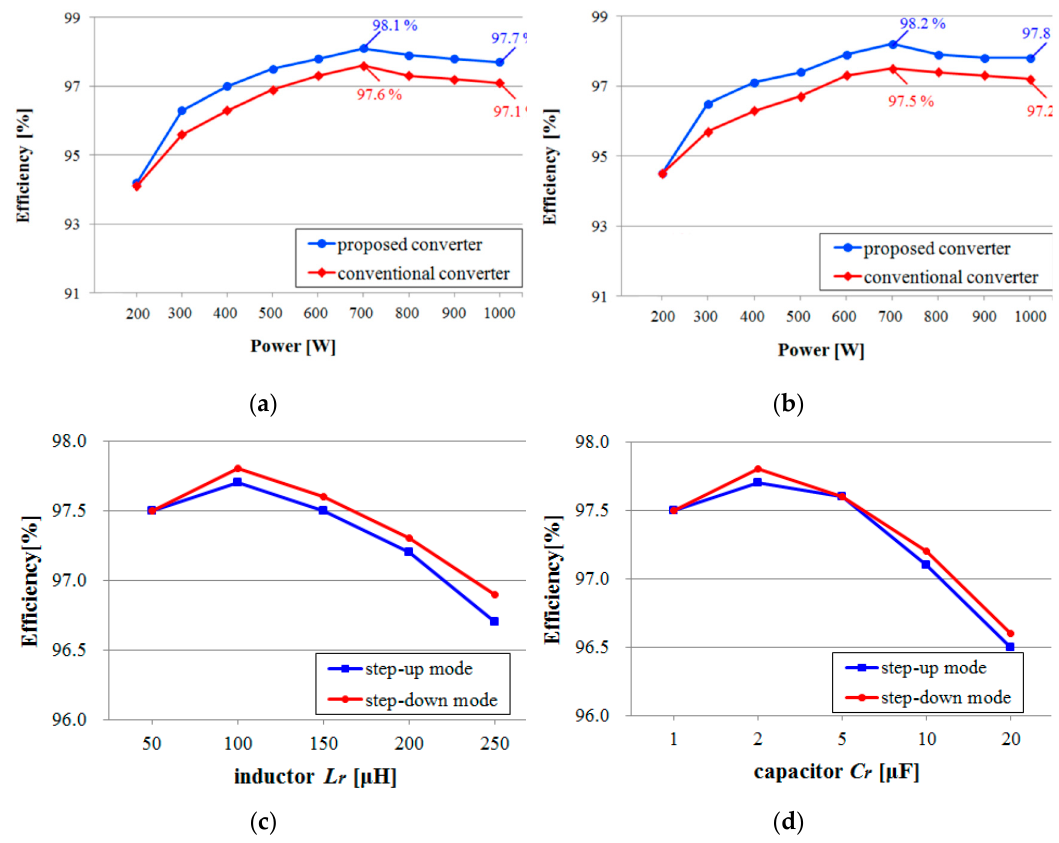
Figure 12. The power efficiency curves of the converters: ( a ) Power efficiency curves in the step-up mode; ( b ) Power efficiency curves in the step-down mode; ( c ) Power efficiency curves for different inductor values of L r at the rated power; ( d ) Power efficiency curves for different capacitor values of C r at the rated power.